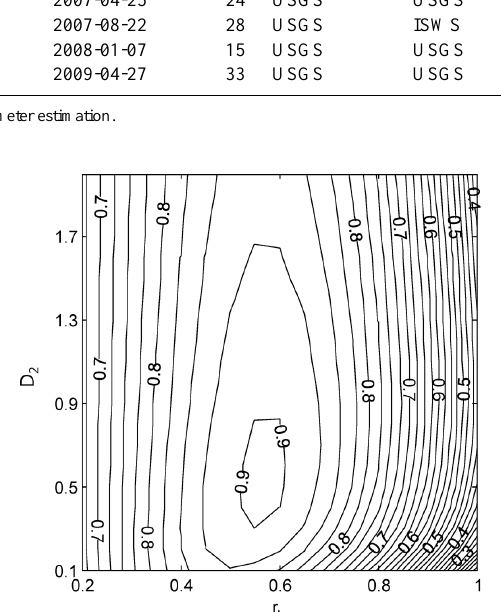
Fig. 5. The model efficiency, E , as a function of diffusion coeffi- cient, D 2 , and contributing ratio of pervious area, r b